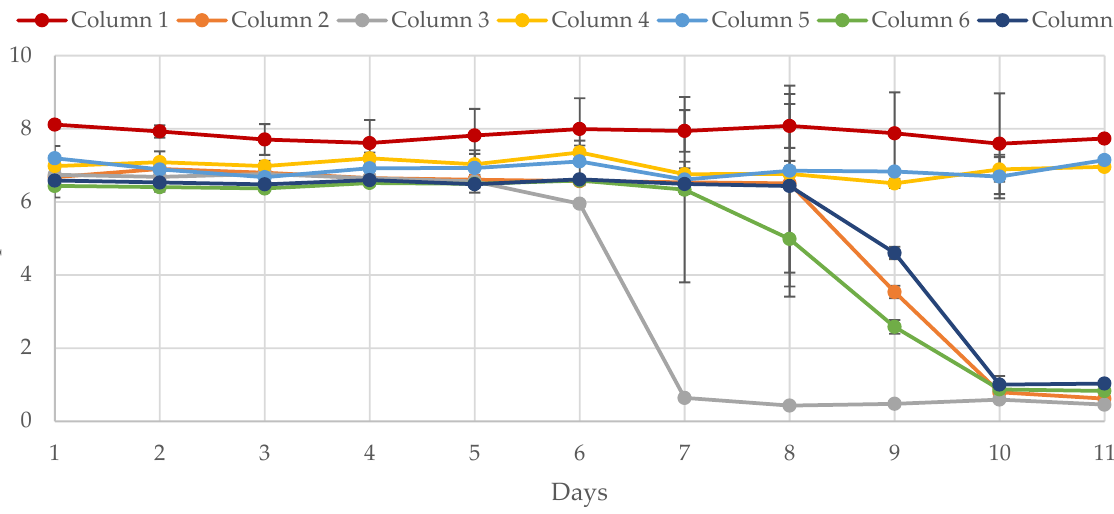
Figure 4. Daily effluent pH measurements used to compare neutralization efficiencies and end-points.